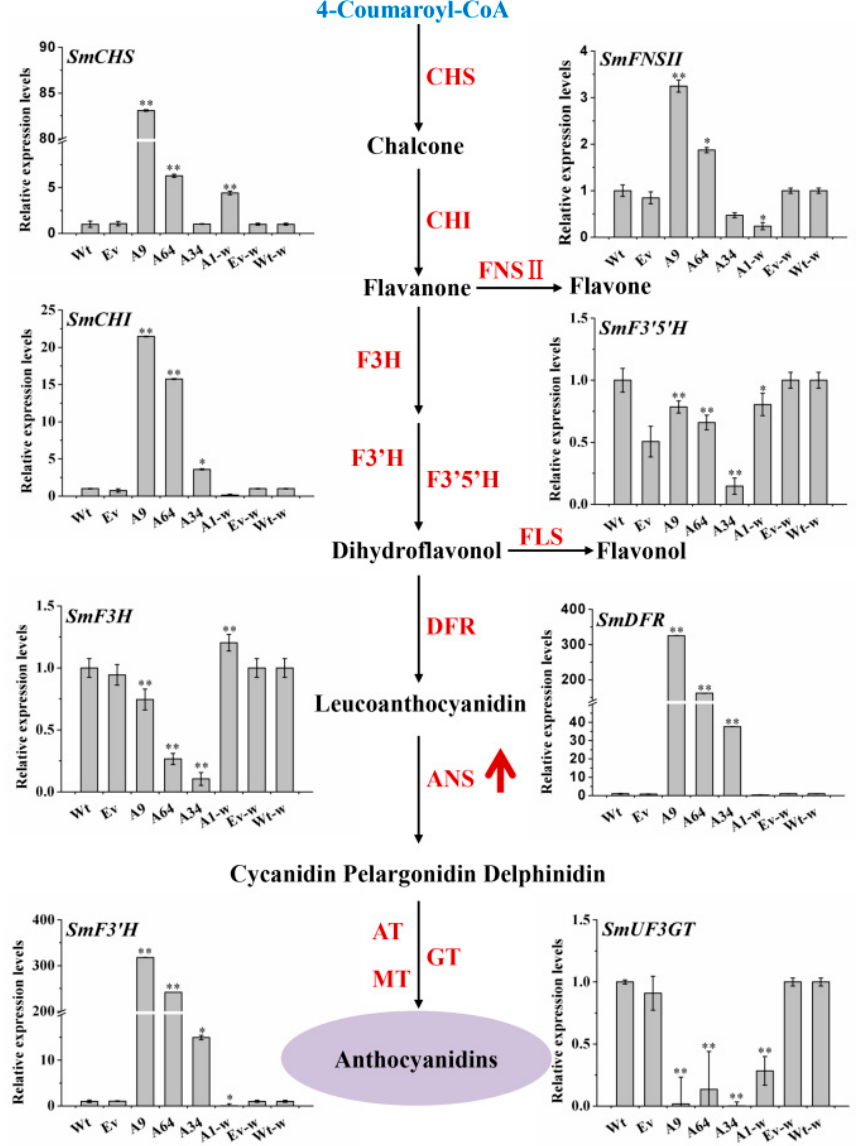
Figure 6. The expression pattern of the flavonoids structure genes in the transgenic lines. The black solid arrows represent the catalytic reactions. The upward red arrow represents the overexpression of the SmANS gene. Wt, the controls that were untransformed wild Salvia miltiorrhiza plants. Ev, the controls that only transformed the empty vector in S. miltiorrhiza . A9, A64, and A34, three transgenic lines of SmANS -overexpressed in S. miltiorrhiza . A1-w, transgenic line of SmANS -overexpressing in S. miltiorrhiza Bge f. alba . Ev-w, the controls that only transformed the empty vector in S. miltiorrhiza Bge f. alba . Wt-w, the controls that were untransformed wild S. miltiorrhiza Bge f. alba plants. The vertical bars show the SD values from three independent biological replicates. (*) indicated a significant difference (0.01 < p < 0.05). (**) indicated a very significant difference ( p < 0.01).